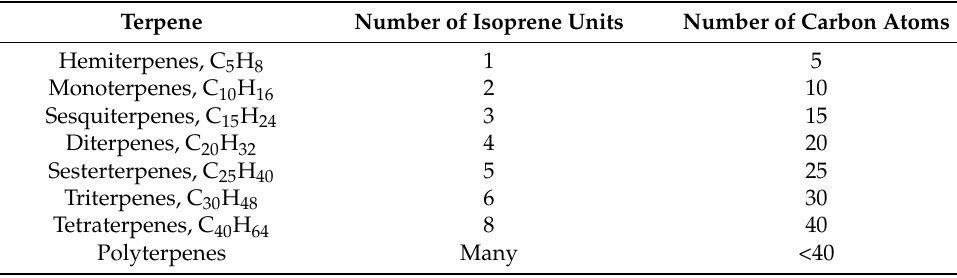
Table 1. Classification of Terpenes.